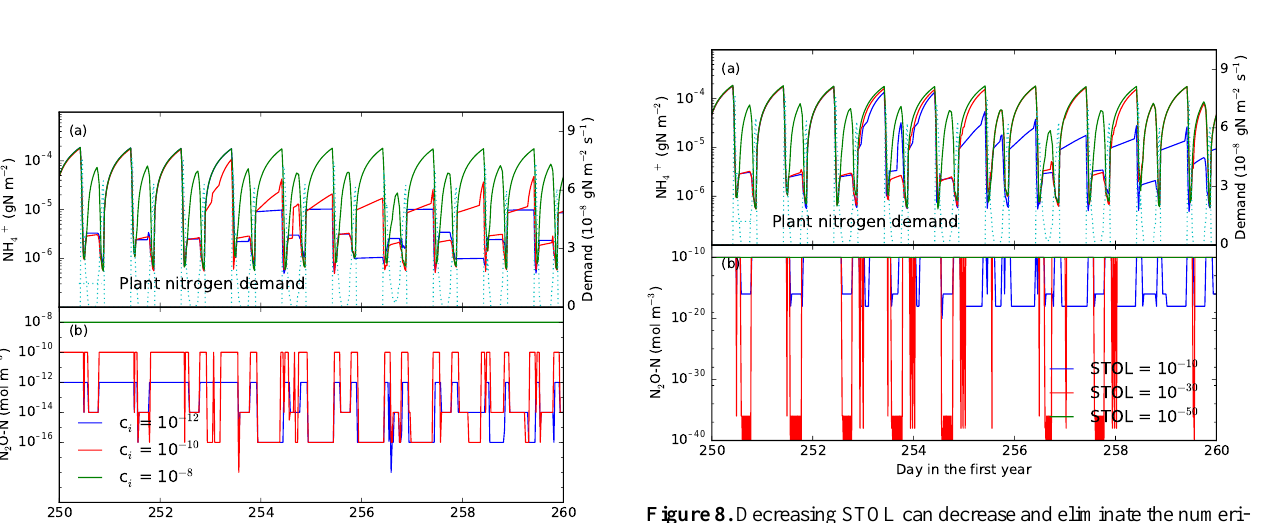
Figure 6. Calculated LAI and nitrogen distribution among vegetation, litter, SOM, NH + site.